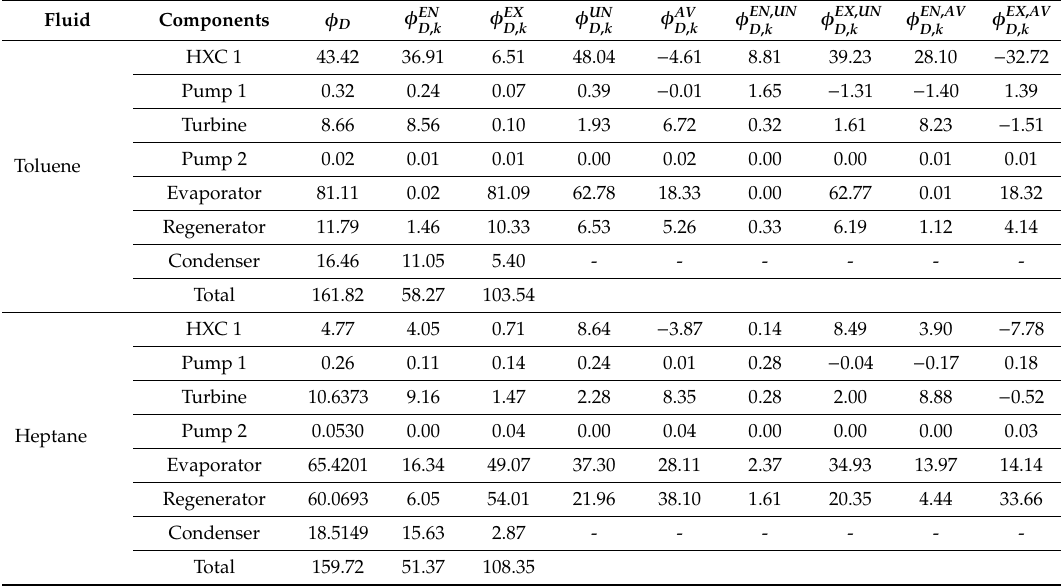
Table A3 shows the breakdown of exergy using toluene and heptane as working fluids. Table A3. Disaggregation of exergy in the RORC system devices for toluene and heptane. Fluid